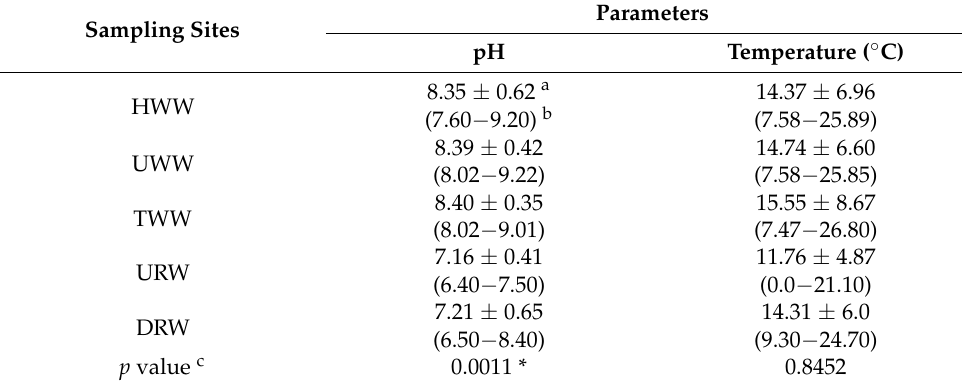
Table 1. Physicochemical properties of wastewater and river water. Sampling